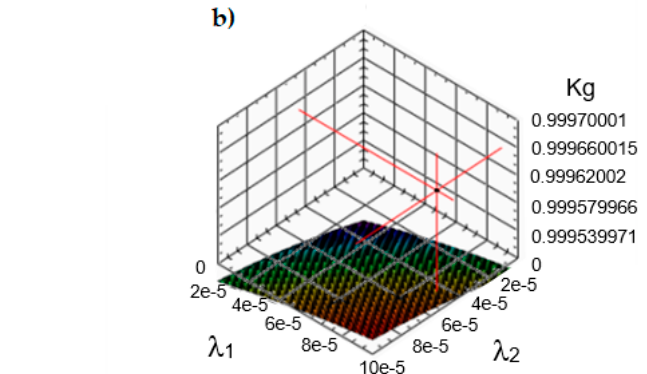
Figure 5. Graphs of the K g availability coefficient in the process of testing the reliability of wind farm devices by changing the value of the average repair time for constant parameters, including: type I mean service time = 0.8 [h]; type II mean operating time = 1.3 [h]; mean time between successive failures = 1200 [h]. where: ( a ) average repair time 0.5 [h]; ( b ) average repair time 0.6 [h].